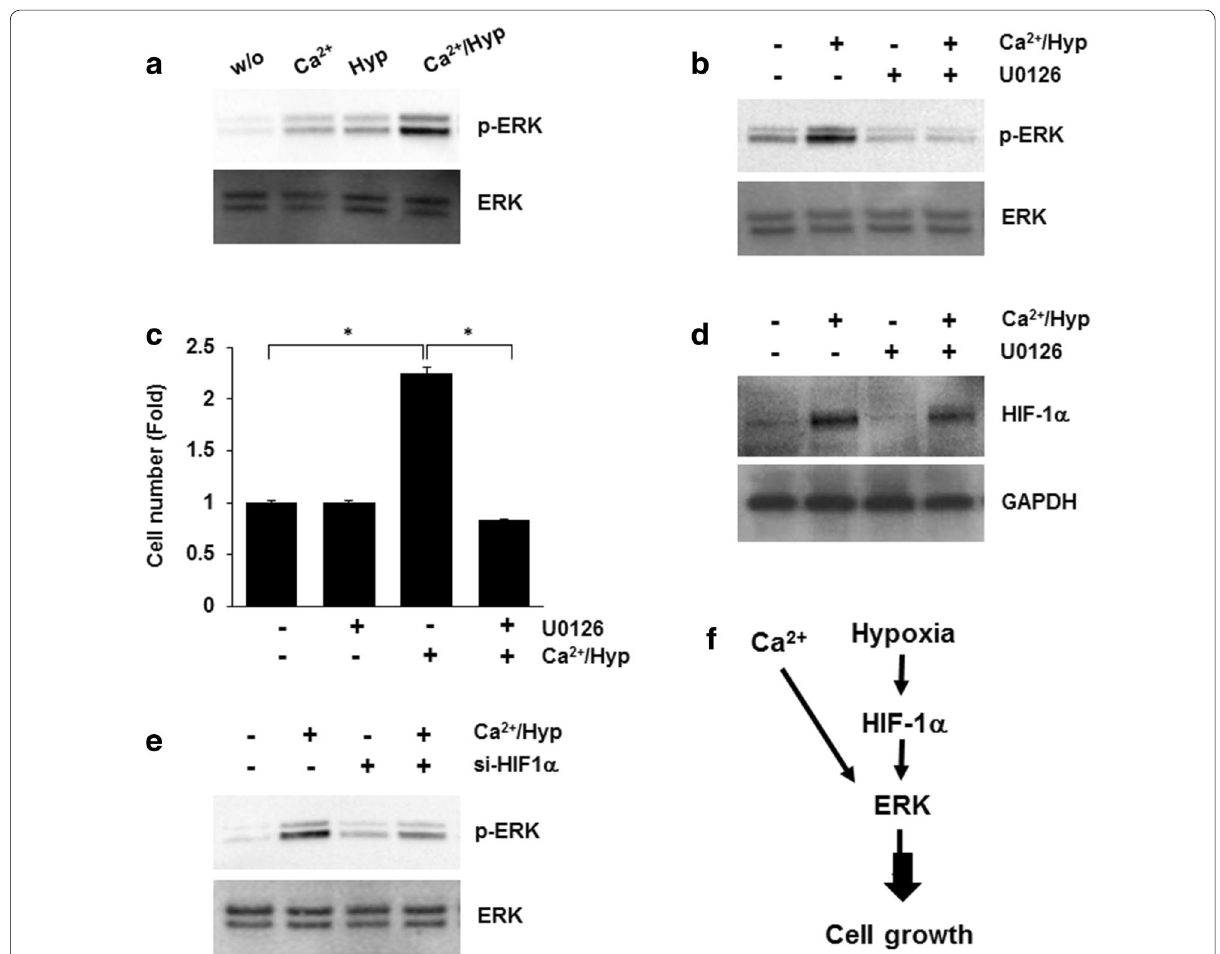
Fig. 4 The role of ERK in the Ca 2 + /hypoxia‑mediated enhancement of hUCB‑MSC proliferation. a hMSCs were treated with Ca 2 + /hypoxia and then harvested after 30 min. The phosphorylation of ERK was determined by western blot analysis. b hMSCs were treated with Ca 2 + /hypoxia for 30 min in the absence or presence of U0126. The phosphorylation of ERK was analyzed by western blot analysis. c hUCB‑MSCs were pretreated with vehicle or U0126 for 30 min and then exposed to Ca 2 + /hypoxia for 5 days. Proliferation capacity was determined by cell counting assays. d hMSCs were treated with Ca 2 + /hypoxia for 6 h in the absence or presence of U0126. HIF‑1α expression was determined by western blot analysis. e At 48 h post‑transfection with HIF‑1α‑specific siRNA (si‑HIF‑1α), hMSCs were cultured under Ca 2 + /hypoxia for 30 min. The phosphorylation of ERK was determined by western blot analysis. f Schematic illustration of the molecular mechanisms involved in Ca 2 + /hypoxia‑induced cell proliferation. Data represent the mean SD, n 3; * P < ± =